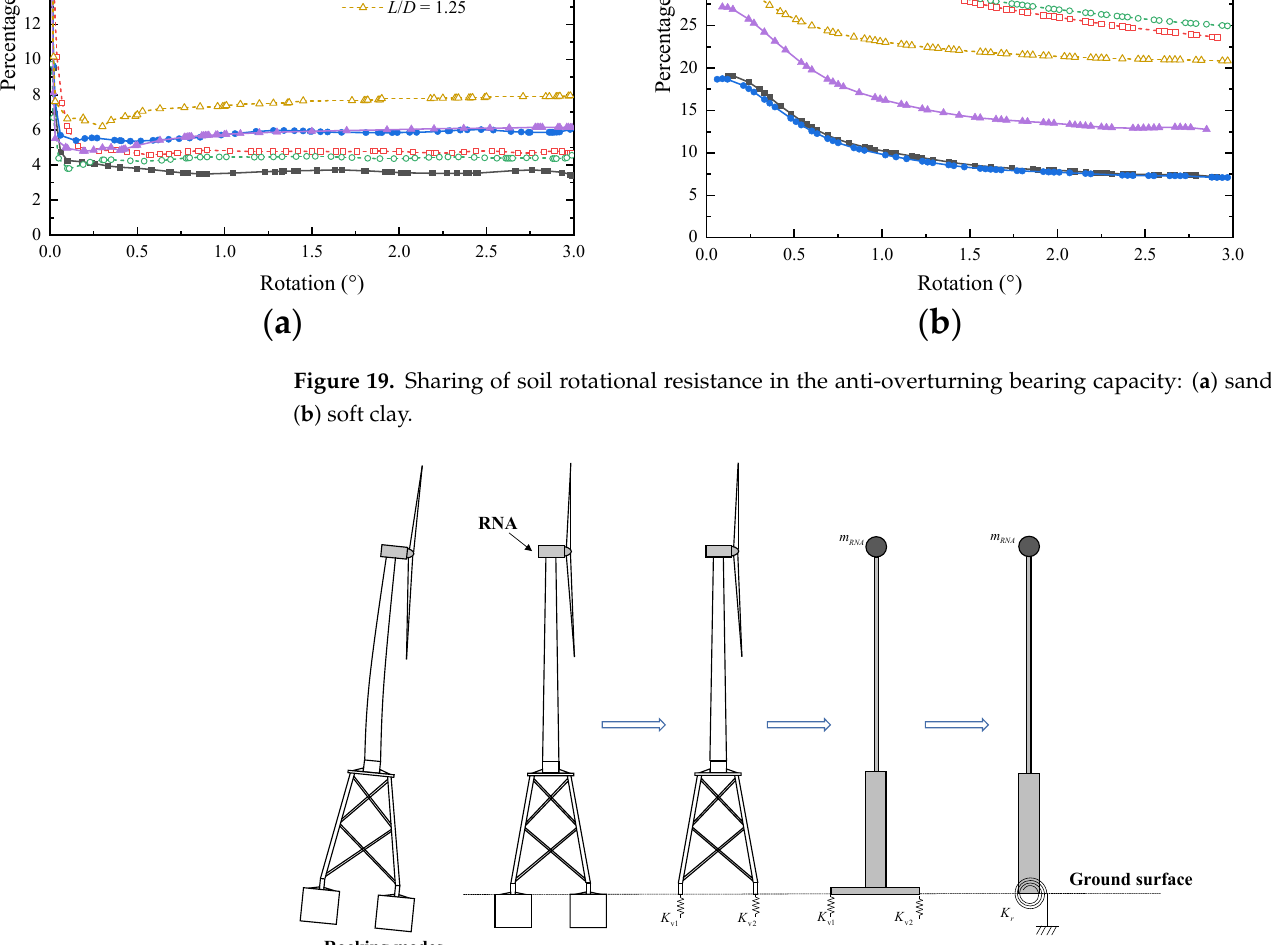
Figure 20. Vibration mode of tripod bucket jacket foundation and its mechanical representation. Figure 21 shows the degradation of rotational stiffness with foundation rotation for tripod bucket foundations in sand and soft clay. The dimensionless rotational stiffness was estimated by adopting M / γ (cid:48) D 4 in sand and M / ADs u (where, A denotes the projected area of the tripod foundation) in soft clay, respectively. It can be seen from Figure 21 that the rotational stiffness of the tripod foundation with varied L / D basically follows a similar degradation pattern. The rotational stiffness of the foundation in sand decreases dramatically with the growth of the rotation angle, while the rate of decline of that in soft clay is relatively slow. Quantitatively, the rotational stiffness of the foundation in sand and soft clay drops to around 50% and 80% of their initial values, respectively, when the rotation angle of the foundation reaches 0.25 ◦ (that is, the maximum allowable inclination of the OWT support structure [9]). This observation is similar to that reported by Wang et al. [11]. It is clear that modal analysis using initial stiffness may overestimate the natural frequency of the OWTs, which can be estimated based on the analytic expression reported in Refs. [5,42]. Subsequently, it may mislead the dynamic and fatigue analysis of the OWT support structure under environmental